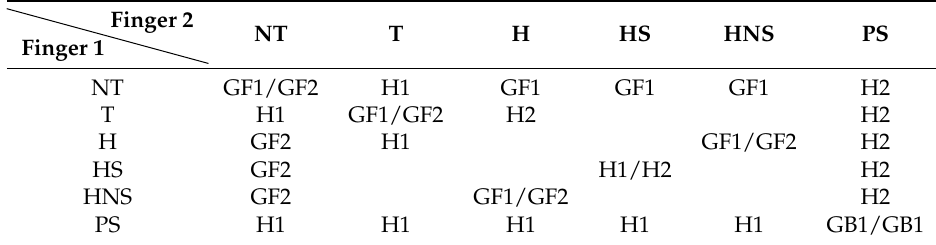
Table 2. Grasp fuzzy controller rulebook.